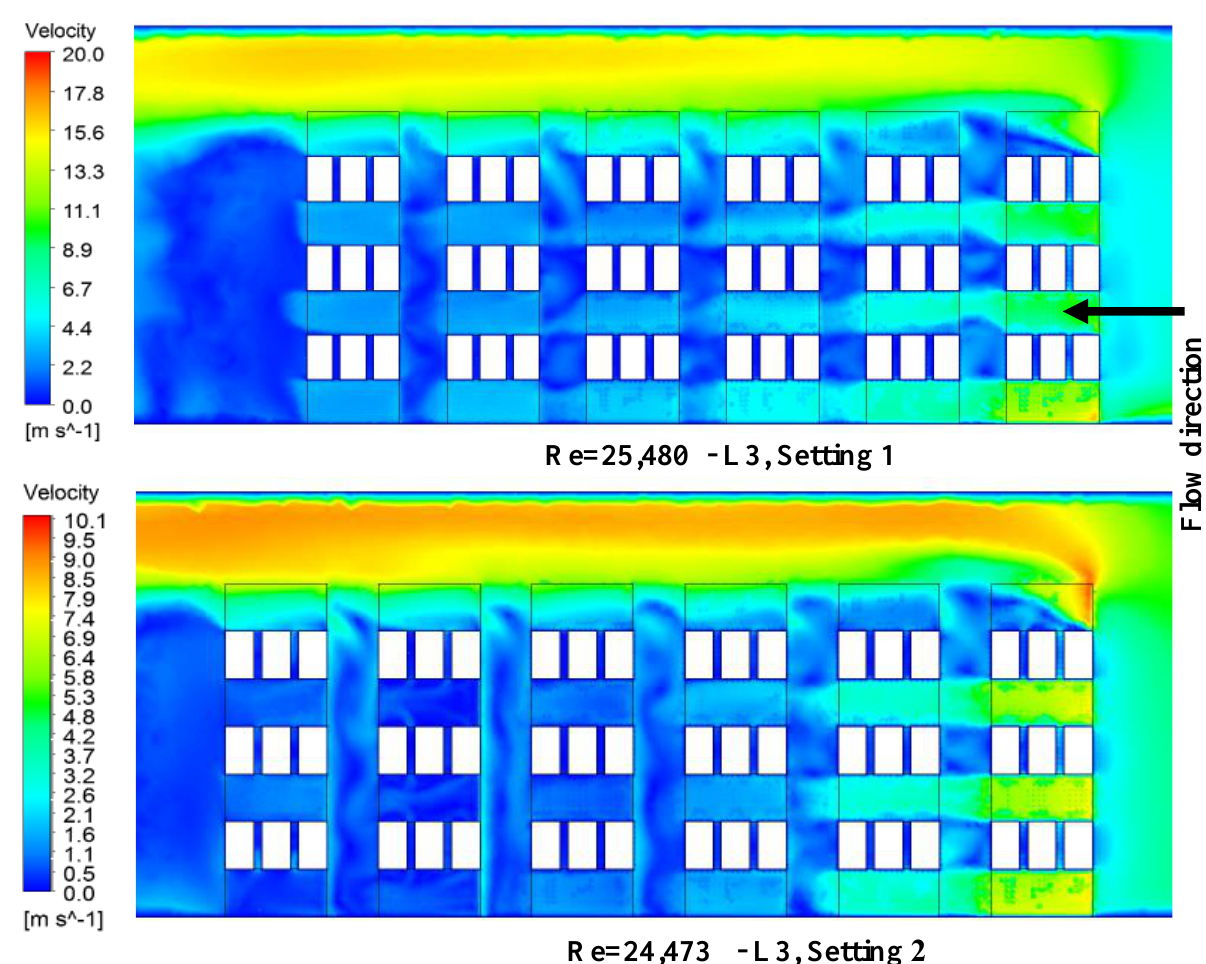
Figure 12. Velocity contours in a longitudinal plane (L3) located in the channel between bricks in the first column.